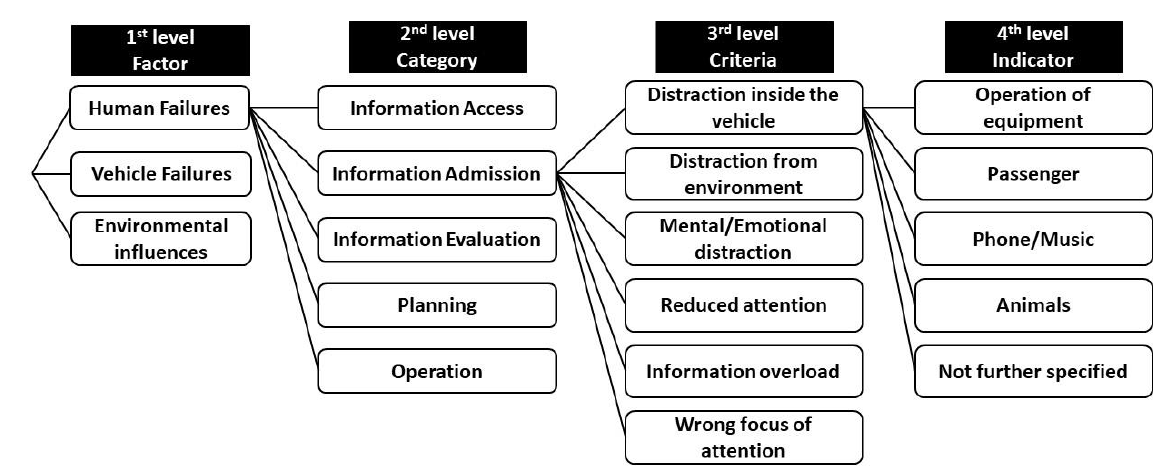
Figure 3. Example of Accident Causation Analysis System (ACAS) classification in German In-Depth Accident Study (GIDAS).